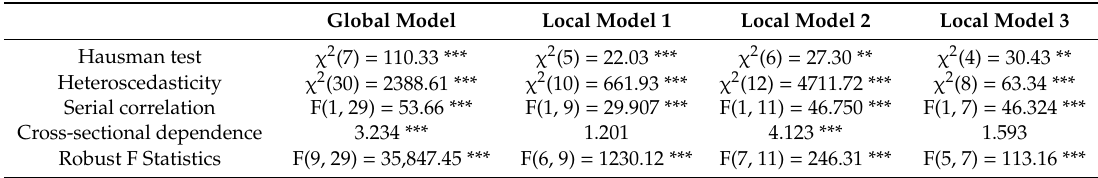
Table 5. Test results for the global model and local